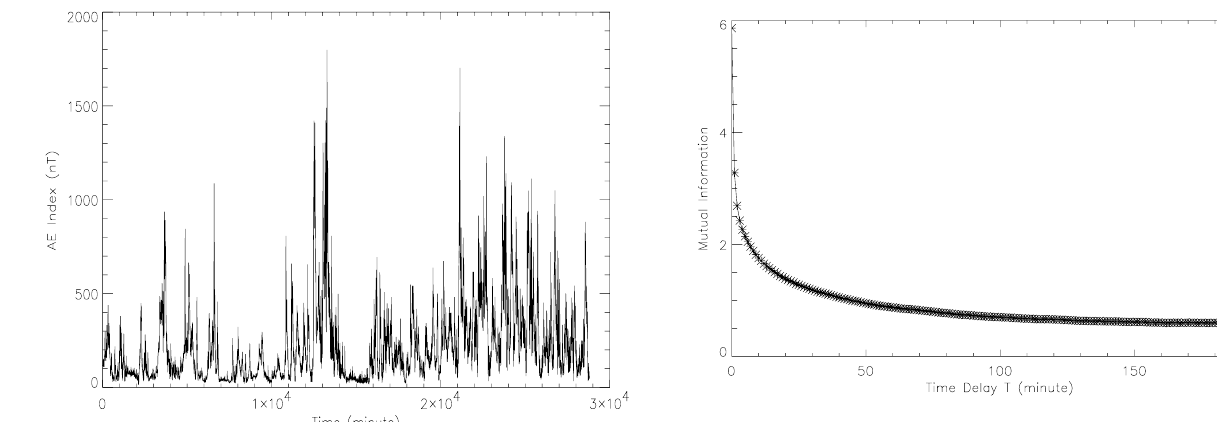
Fig. 2. The mutual information function of the auroral electrojet index AE for January 1983 at 1min resolution (Fig. 1). The charac- teristic time, corresponding to half the peak value, is ∼